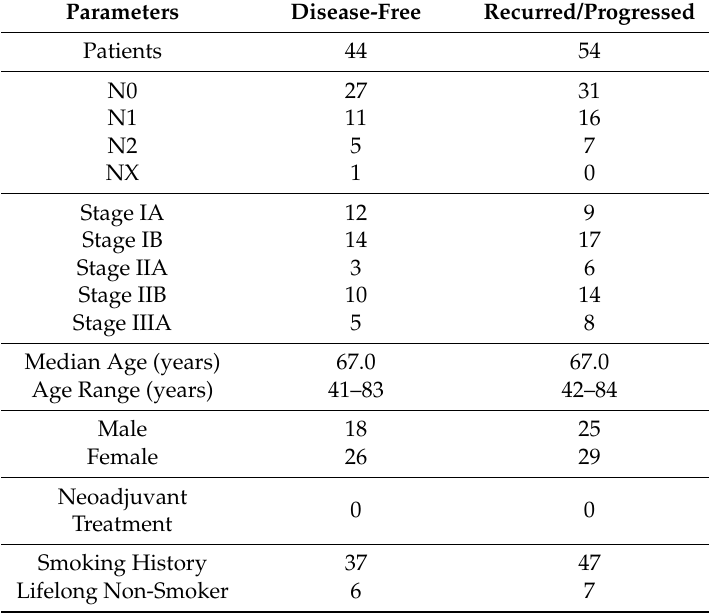
Table 1. Clinical parameters for the 98 lung adenocarcinoma (LUAD) from The Cancer Genome Atlas (TCGA) samples categorized based on the clinical outcome of tumor